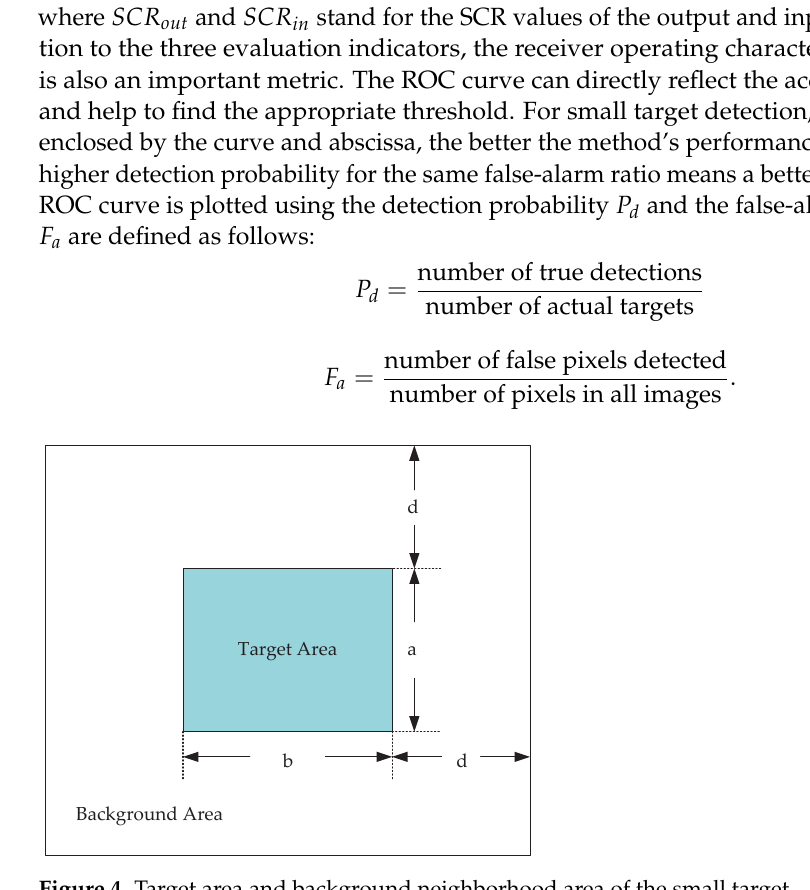
Figure 4. Target area and background neighborhood area of the small